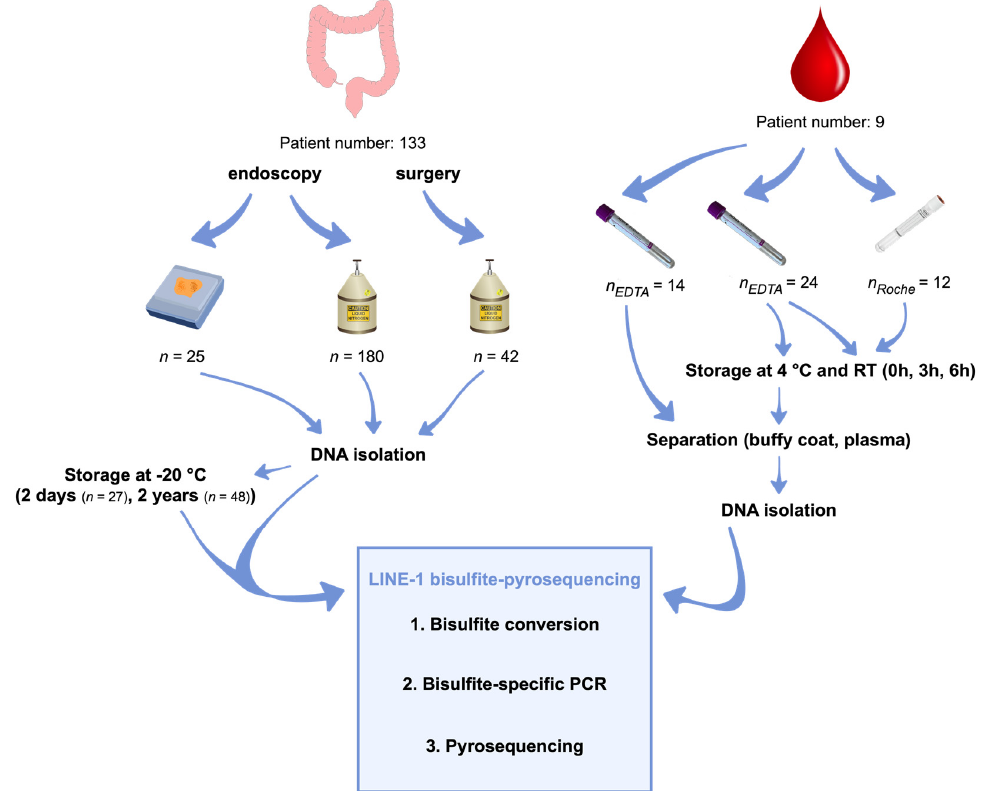
Figure 7. Summary of the sample collection and applied methods. Following the sample collection and fixation, DNA was isolated from colorectal N, AD, CRC, IBD along with paired AD-NAT and CRC-NAT tissue biopsies (patient number = 133). To investigate the impact of storage time, 27 specimens were analyzed after 2 days, and 48 samples were kept at − 20 °C for 2 years before further examinations. Blood samples were collected into standard K3EDTA tubes to investigate the influence of physical activity on LINE-1 methylation results (patient number = 5). Furthermore, blood samples taken into conventional K3EDTA and Cell-Free DNA Collection Tubes were kept at RT and 4 °C for 0 h, 3 h, and 6 h to analyze the effect of different collection tubes, storage time, and temperature on LINE-1 methylation (patient number = 4). Buffy coat and plasma fractions were separated, and DNA specimens were isolated. Finally, DNA samples were bisulfite-converted followed by bisulfite-specific PCR of the LINE-1 promoter region, and the amplicons were pyrosequenced.